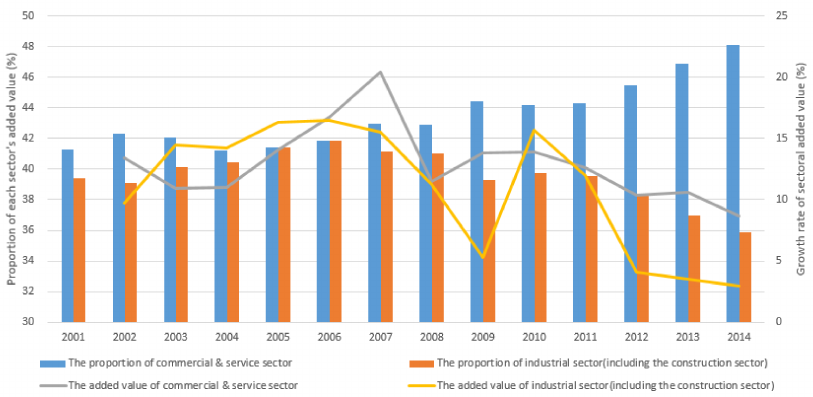
Figure 3. The Change of China’s Economic Structure from 2001 to 2014 [3].